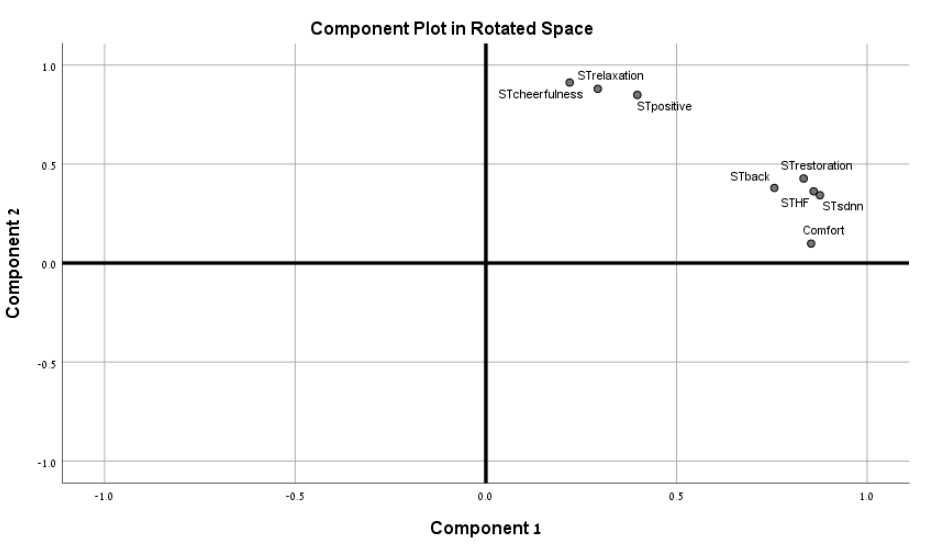
Figure 4. Components plot. Table 2. Rotated Component Matrix.